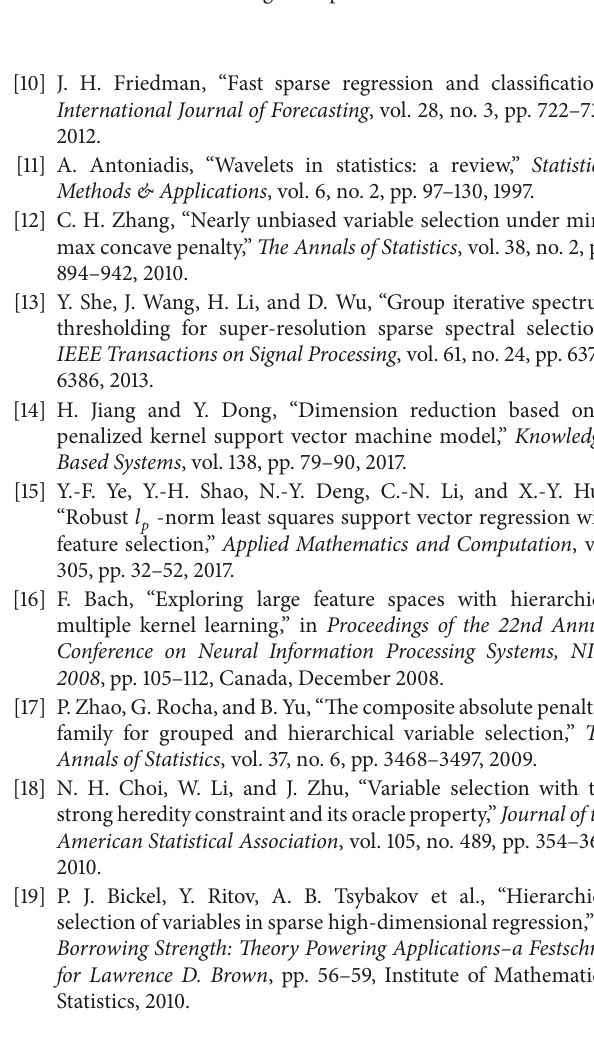
Figure 5: Sparsity pattern of compared forecasting methods in the inbred mouse gene expression